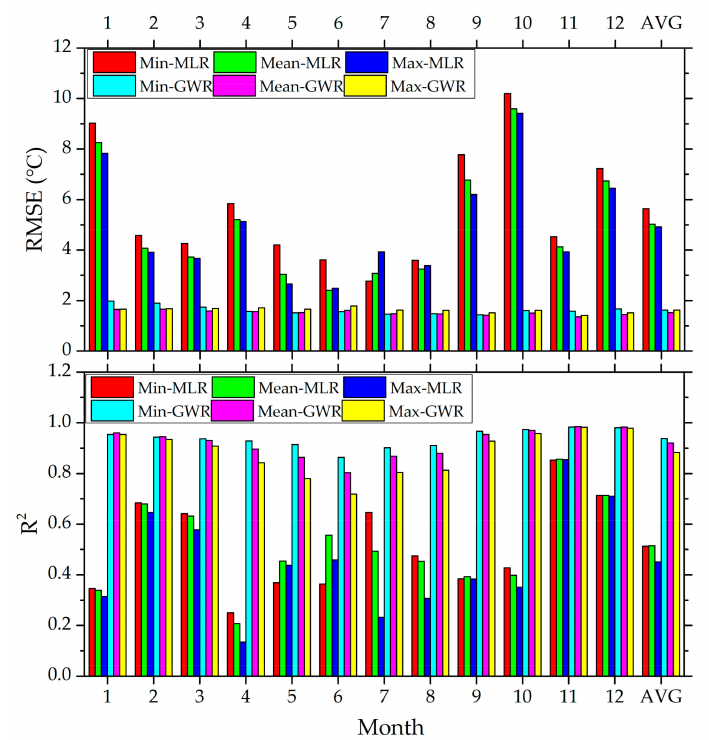
Figure 2. RMSE and R 2 of the predicted monthly near surface air temperature (NSAT) using the multiple linear regression (MLR) and geographical weighted regression (GWR) in China in 12 months of 2010. Min-MLR represents predicting monthly minimum NSAT using the MLR model, Mean-MLR represents predicting monthly mean NSAT using the MLR model, Max-MLR represents predicting monthly maximum NSAT using the MLR model, Min-GWR represents predicting monthly minimum NSAT using the GWR model, Mean-GWR represents predicting monthly mean NSAT using the GWR model, and Max-GWR represents predicting monthly maximum NSAT using the GWR